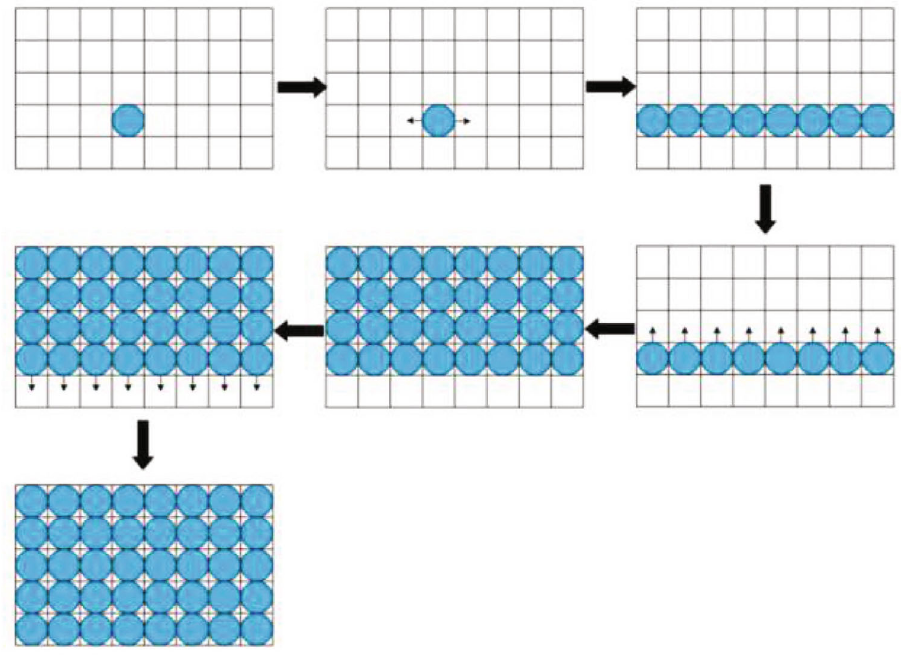
Figure 3: Schematic map of location XOR di ff